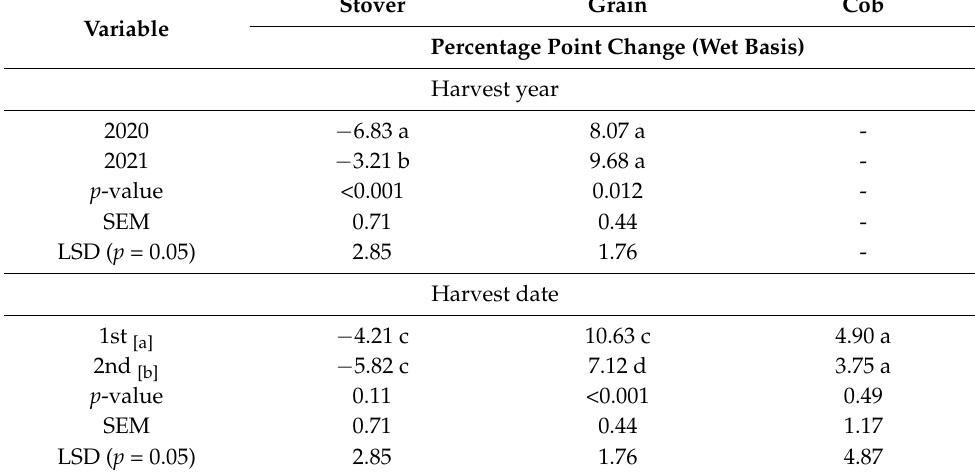
Table 4. Reported moisture content changes (percentage points wet basis) for the stover, grain, and cob fraction.